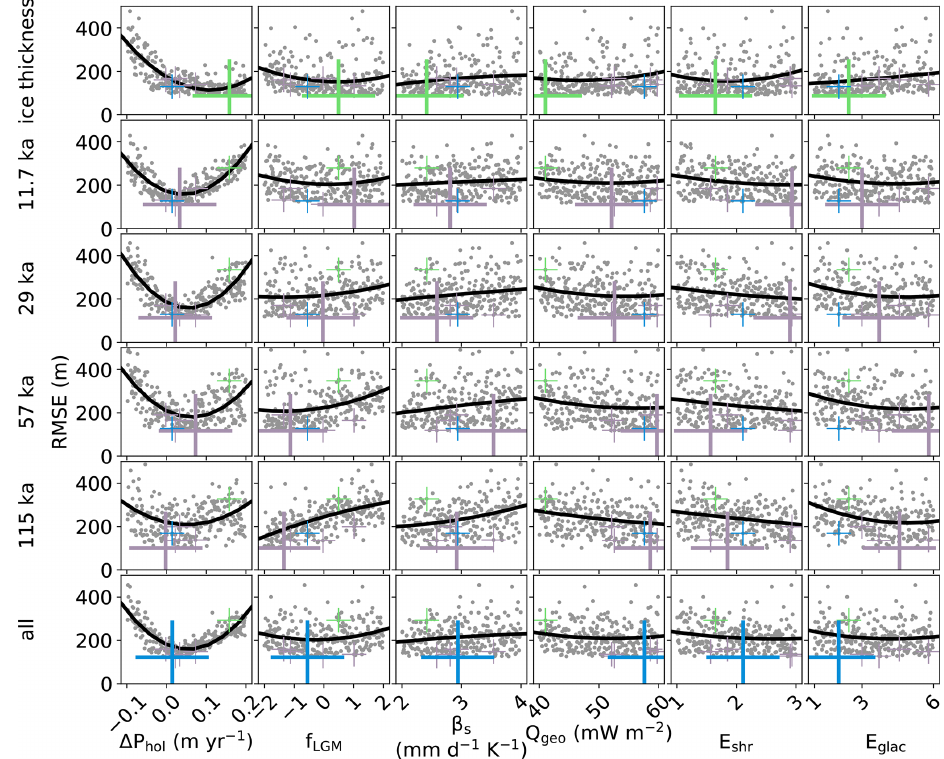
Figure 8. RMSE of ice thickness and isochrone depth for the six tuning parameters. The bottom row shows the RMSE of all isochrones and the total ice thickness together. Individual simulations are marked with gray dots, and large crosses mark the location of the best simulation for each metric as indicated on the left. Smaller crosses of the same color mark the location of the same simulations in the other metrics. A black line illustrates a second order polynomial